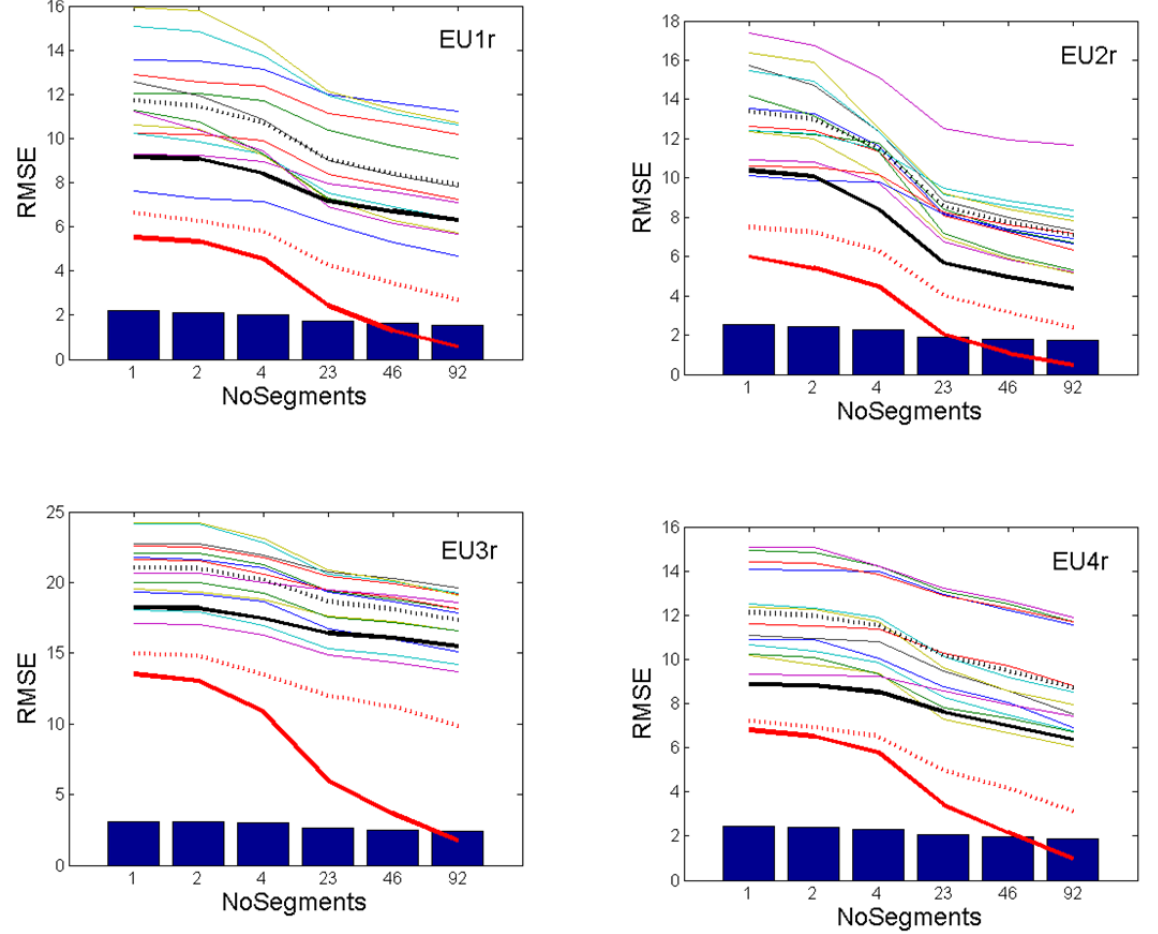
Figure 4. The mean RMSE of the models (coloured lines) as a function of window size (1–92 days). In addition, selected ensemble products are also displayed: mme (thick black), < mmi > (thick dotted-black), mmeW (thick red), mmeS (thick dotted red). The bars show the theoretical minimum value (varnm − 1 ) for uncorrelated models. Please note the different range of the y -axis between the different panels.